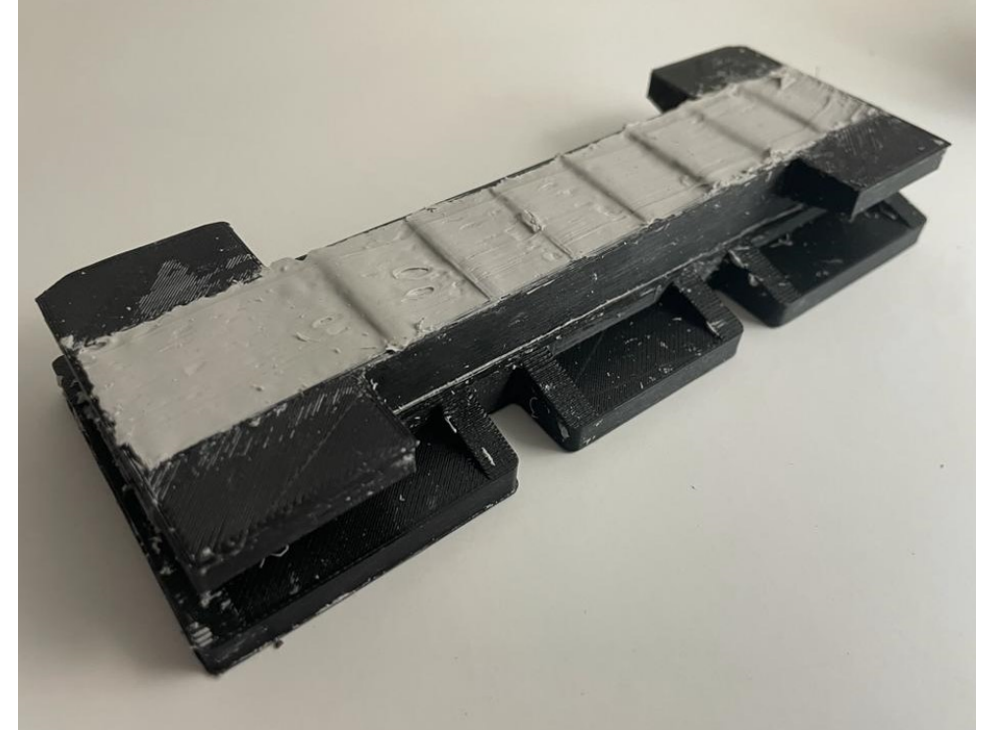
Figure 5. 3D-Printed Mold with Curated Hyper-elastic